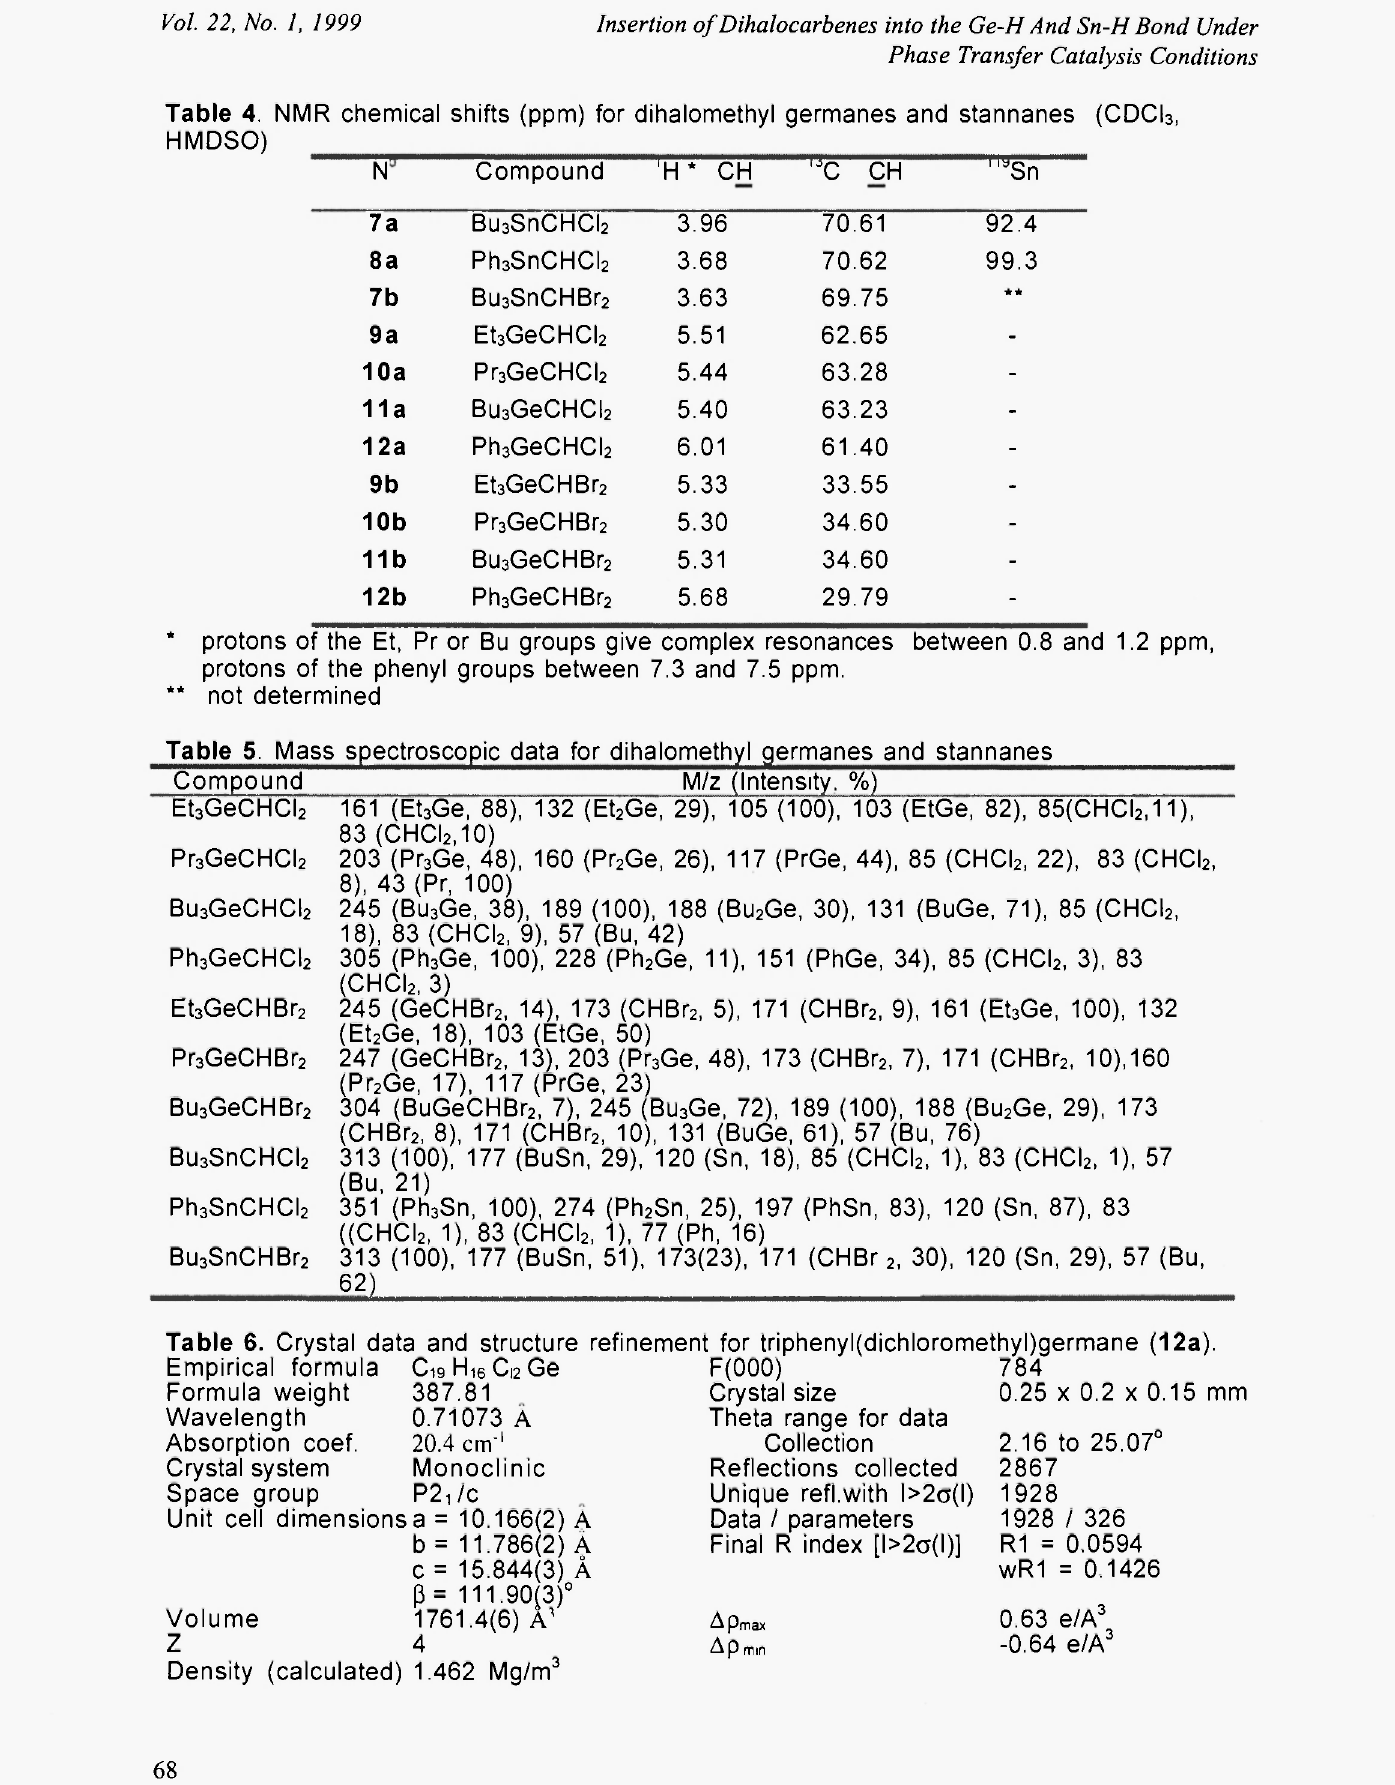
Volume Density (calculated) 1.462 Mg/m